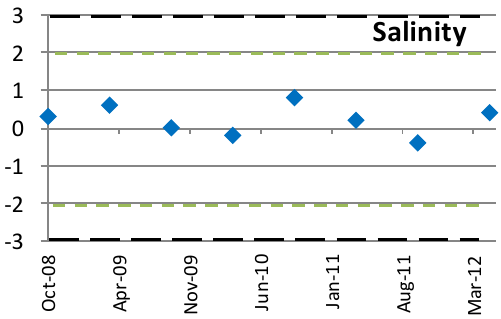
Figure 5. z scores of 8 QUASIMEME rounds of salinity in the ma- Figure 5 z-scores of 8 QUASIMEME rounds of salinity in the marine environment between rine environment between October 2008 and May 2012, where the October 2008 and May 2012, where the green dashed lines indicate a z-score of 2. The dashed green dashed lines indicate a z score of 2. The dashed black line at a z score of ± 3 designates unsatisfactory black line at a z score of ±3 designates unsatisfactory performance.